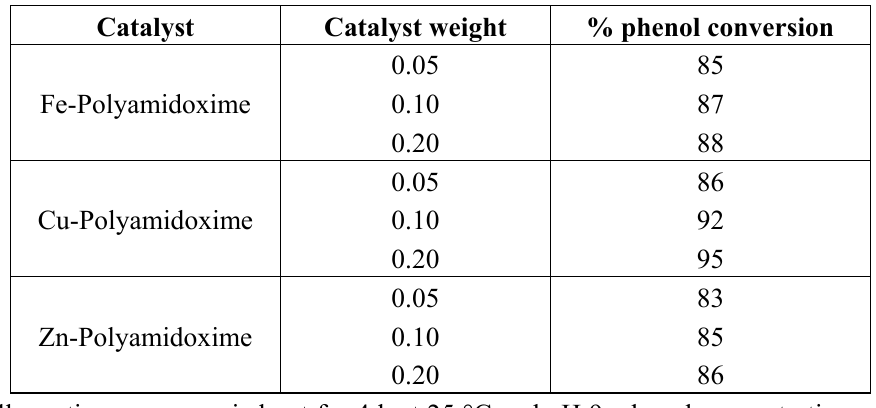
Table 2. Effect of amount and catalyst